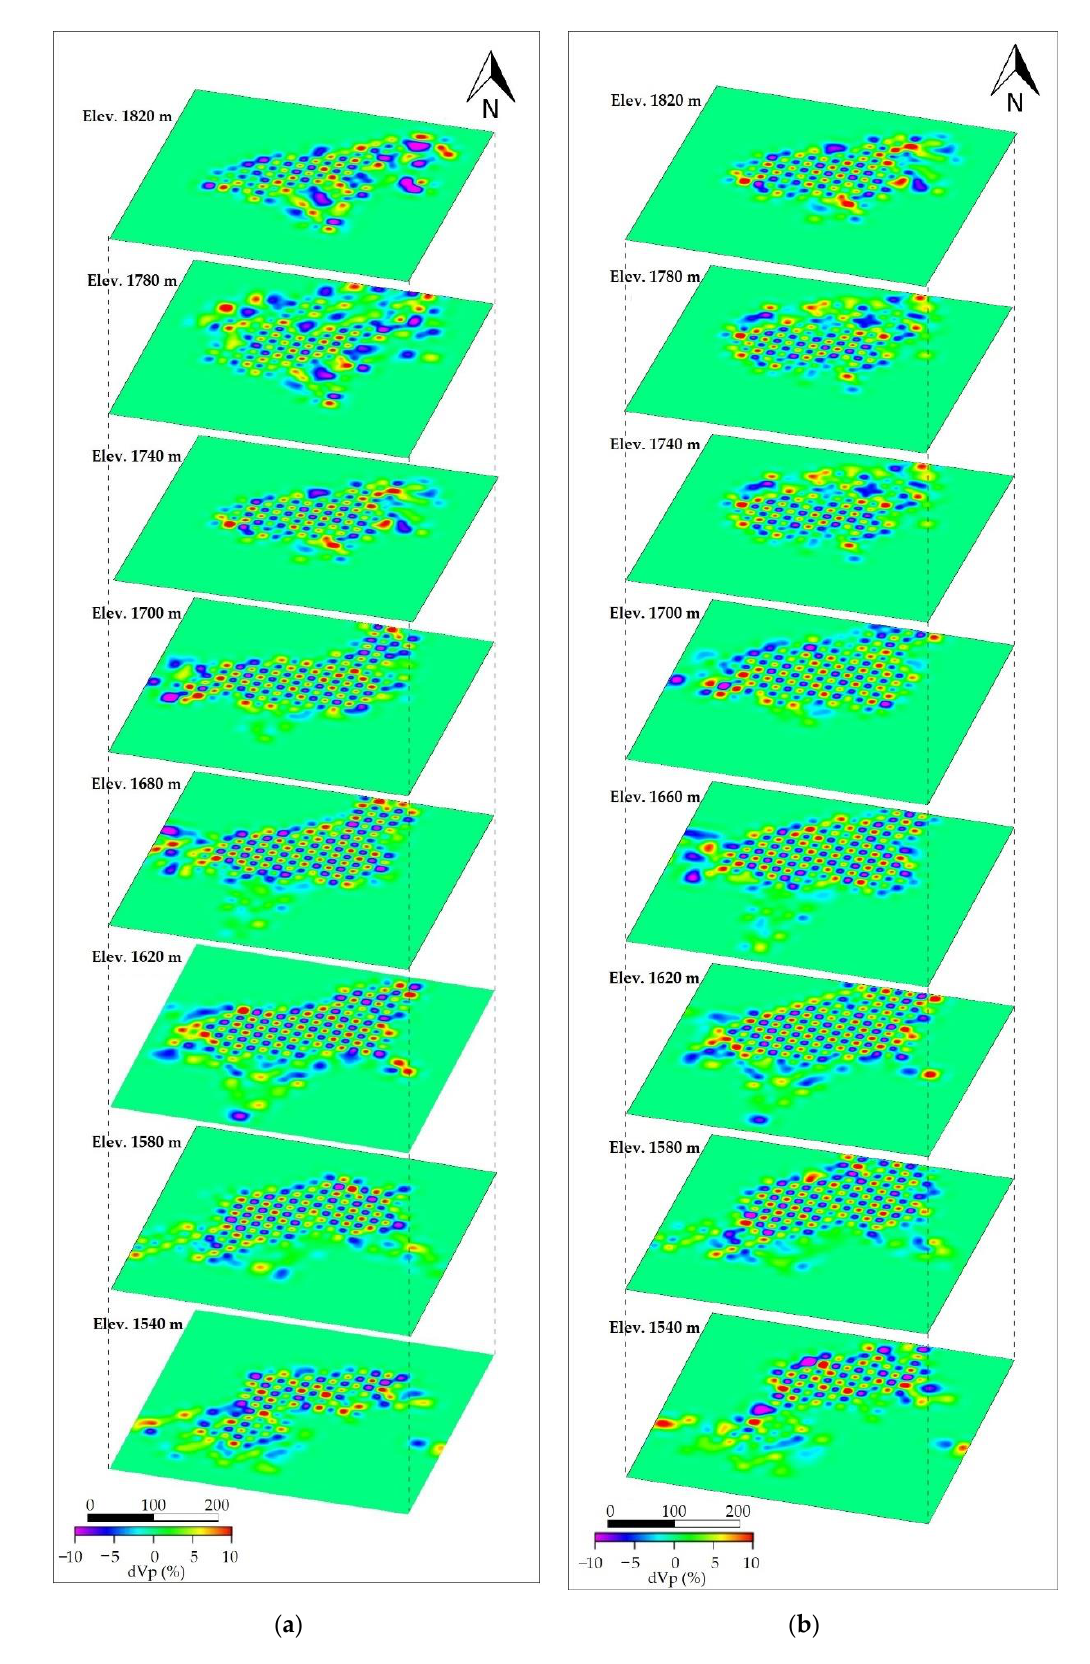
Figure 7. ( a ) Checkerboard Resolution Test Vp following the facility for each elevation at 1540 – 1820 (interval 40 m). ( b ) Checkerboard Resolution Test Vp following the off-facilities area for each elevation at 1540 – 1820 (interval 40 m).